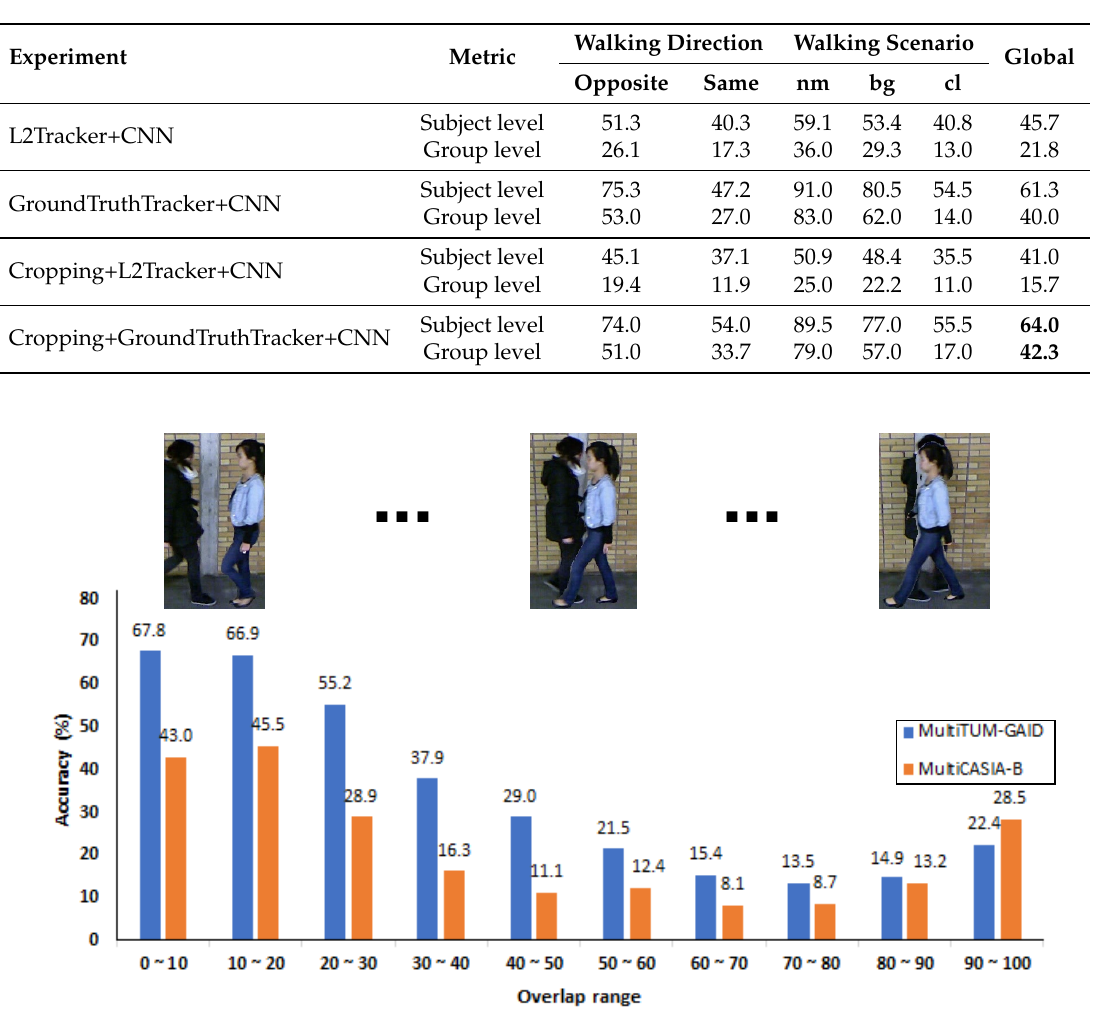
Figure 7. Accuracy under different grades of overlap. Each bar represents the accuracy of a different grade of overlap of the subjects present in a sample. More details in the main text. Blue bars correspond to TUM-GAID results, while orange bars correspond to CASIA-B